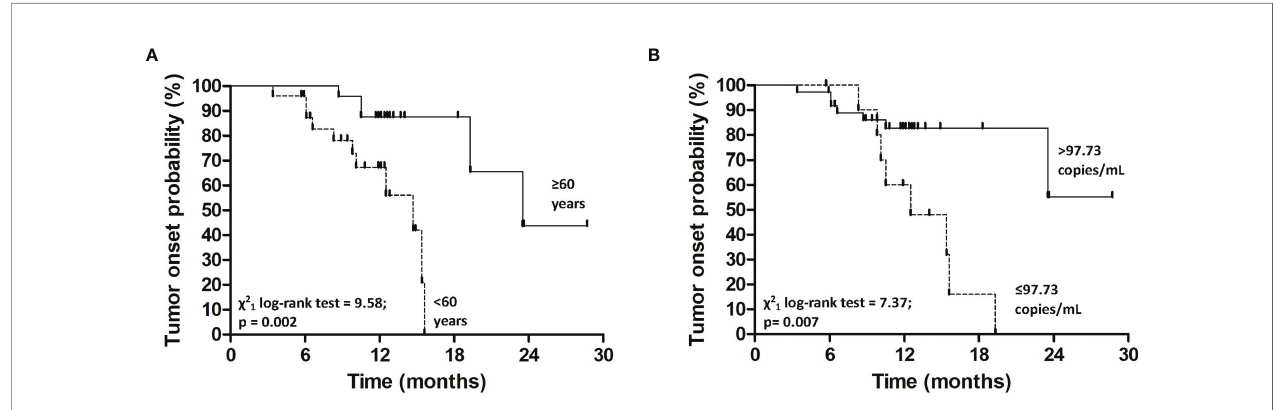
FIGURE 2 | Kaplan-Meier estimates for tumor onset probability according to age (A) and plasma TERT mRNA levels at baseline (B)